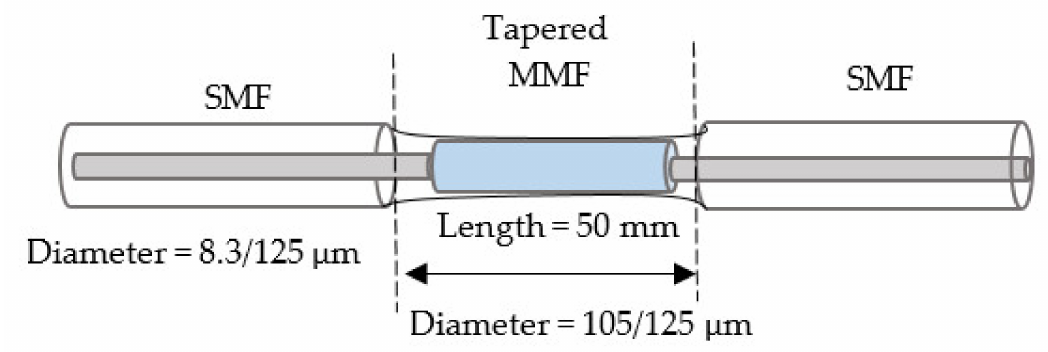
Figure 8. Tapered fiber optic based on multi-taper devices